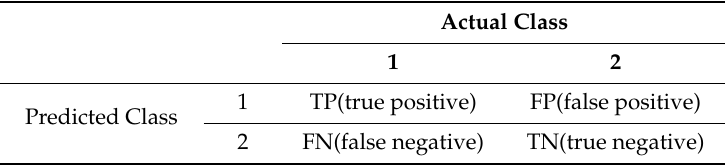
Table 3. Confusion matrix presenting number of true positives, true negatives, false positives, and false negatives for a 2-class classification problem.